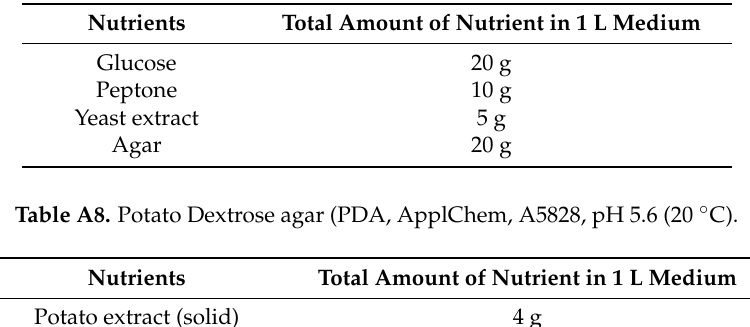
Table A7. Sabouraud (SAB, Pagano, Levin and Trejo, 1958).